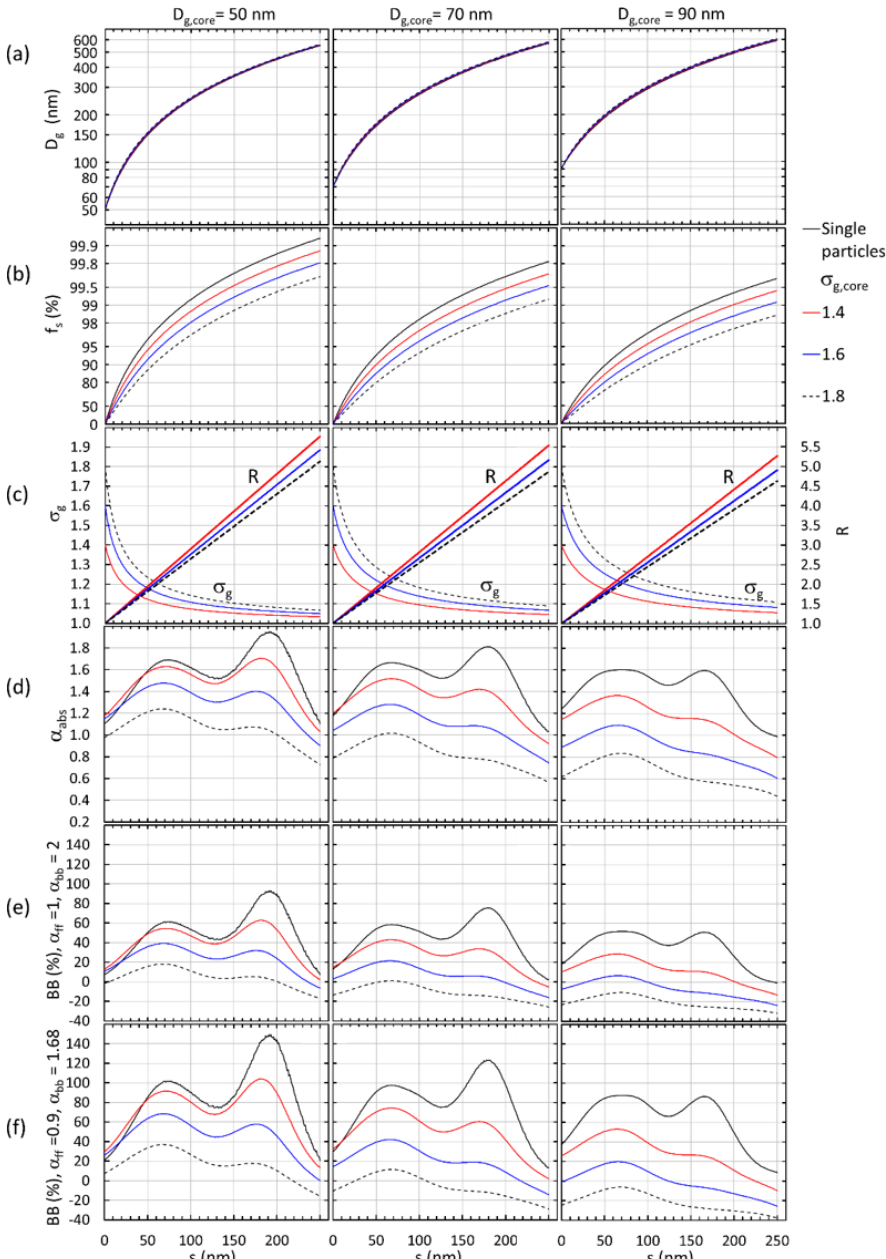
Figure 5. Examples of the growth of a non-size-dependent scattering shell on BC core size distributions with D g , core = 50, 70, and 90nm and on single BC particles. (a) Geometric mean diameter, (b) shell volume fraction, (c) geometric standard deviation and D p -to- D core ratio ( R ), (d) absorption Ångström exponent, (e) BB(%) with the Aethalometer model constants α ff = 1 and α bb = 2, and (d) biomass-burning fraction with the Aethalometer model constants α ff = 0.9 and α bb = 1.68 as a function shell thickness s .